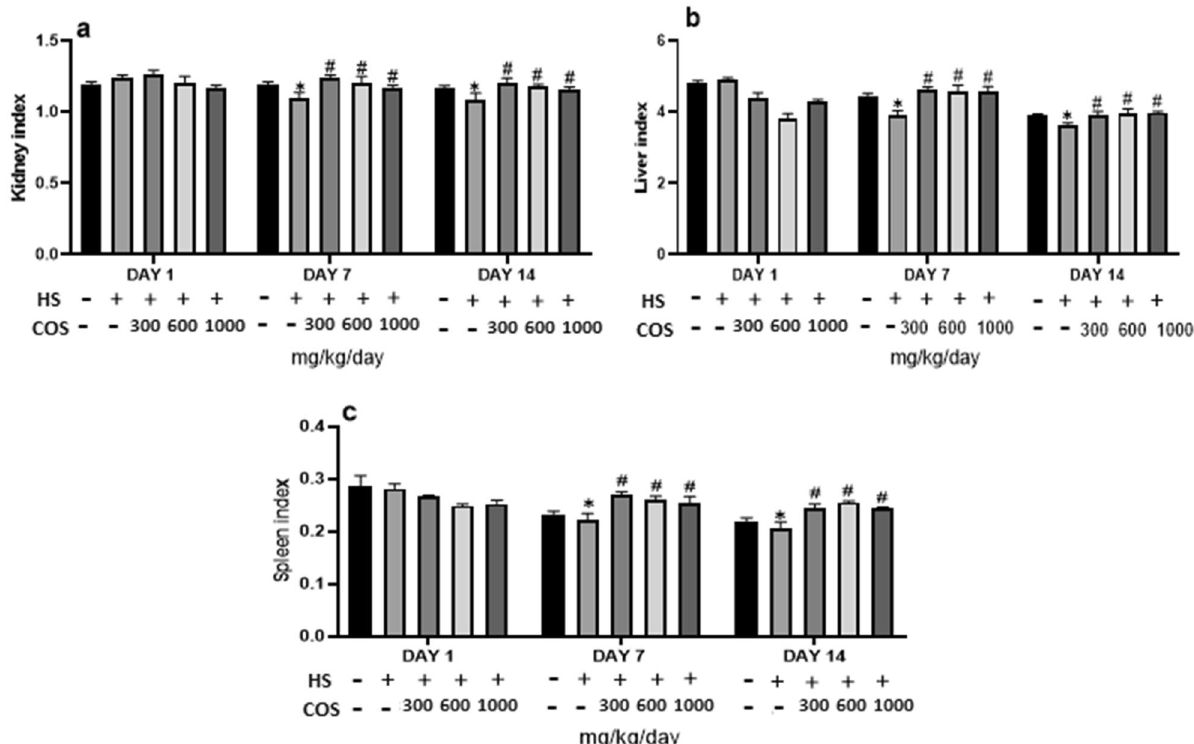
Figure 2. Effect of chitosan treatment on the organ index. Control: normal mice; HS: Heat stress mice; COS-LD: mice treated with HS plus COS (300 mg/kg); COS-MD: mice treated with HS plus COS (600 mg/kg); COS-HD: mice treated with HS plus COS (1000 mg/kg). Data are expressed as mean ± standard error. *Indicates p < 0.05 compared with the blank control group, # indicates p < 0.05 compared with the HS control